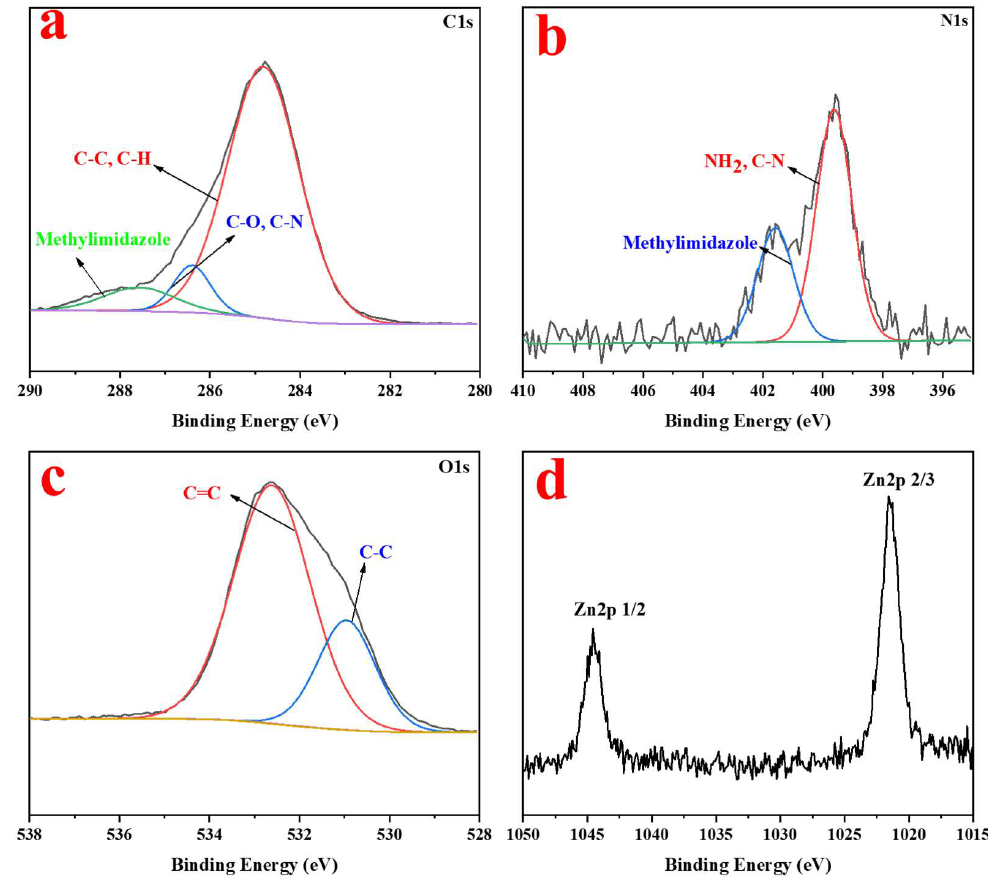
Figure 4. XPS spectra of the surface of the ZIF-8/PPS fiber membranes (( a ): C1s; ( b ): N1s; ( c ): O1s; ( d ): Zn2p).